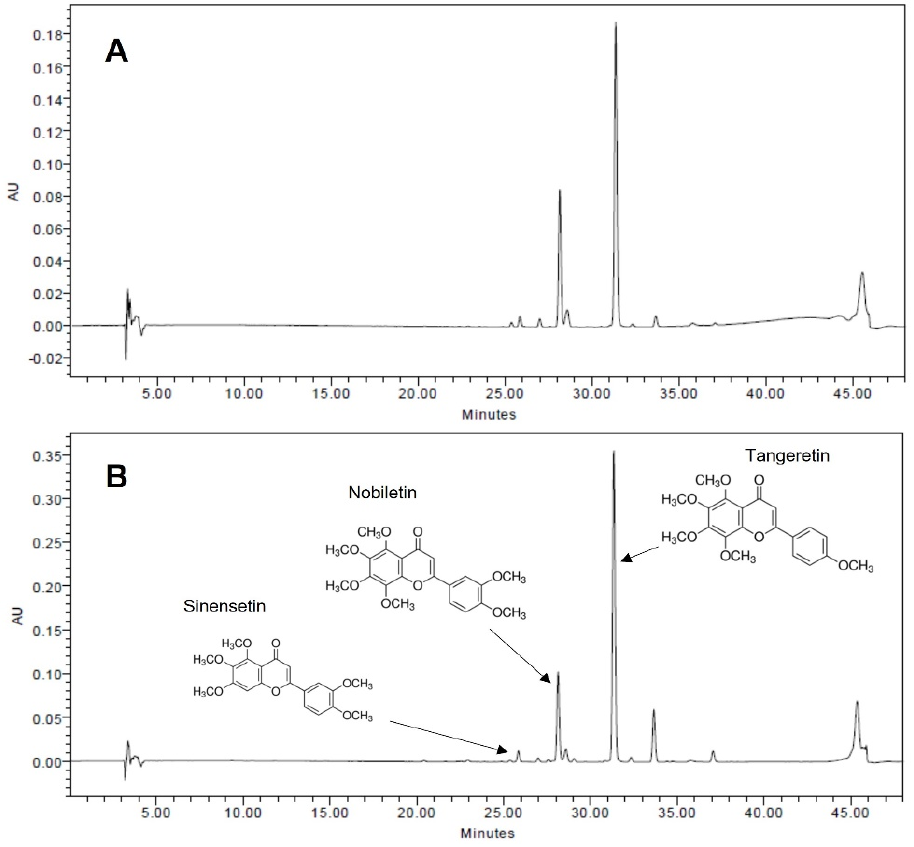
Figure 1. HPLC chromatograms of PMF-rich fraction (PRF) from fruits ( A ) and leaves of Jinkyool ( Citrus sunki Hort ex. Tanaka) ( B ). Tangeretin, nobiletin, and sinensetin were the three major PMFs contained in PRF.